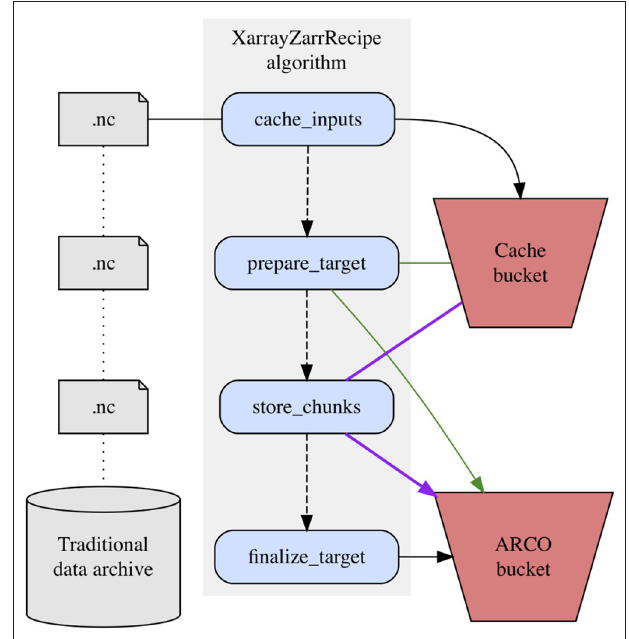
FIGURE 3 | XarrayZarrRecipe